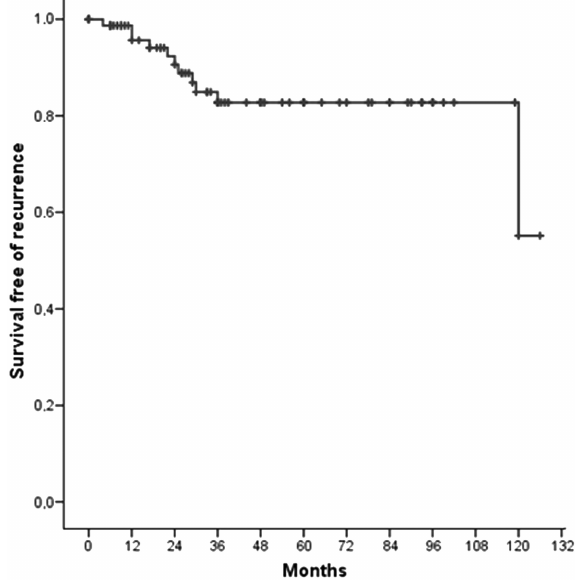
Figure 1. Kaplan-Meier curve showing the rate of survival free of recurrence in meningiomas